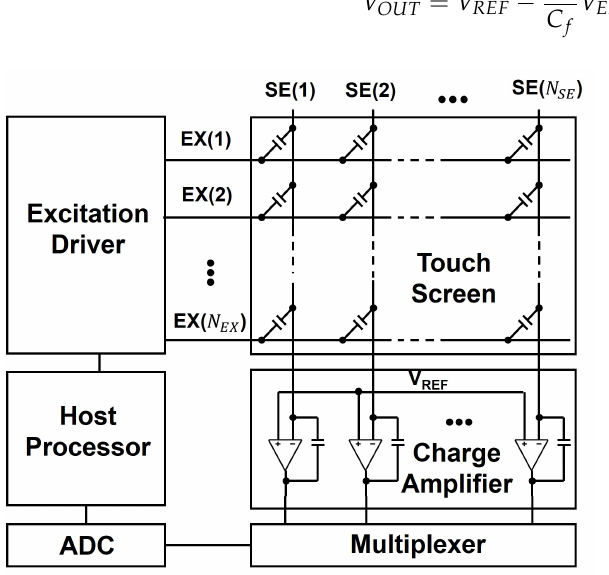
Figure 7. Block diagram of a conventional mutual capacitance capacitive touchscreen system. N EX and N SE are the numbers of excitation and sensing electrodes, respectively. The touch locations are estimated from the mutual capacitor array formed at the intersection areas of EX and SE lines.